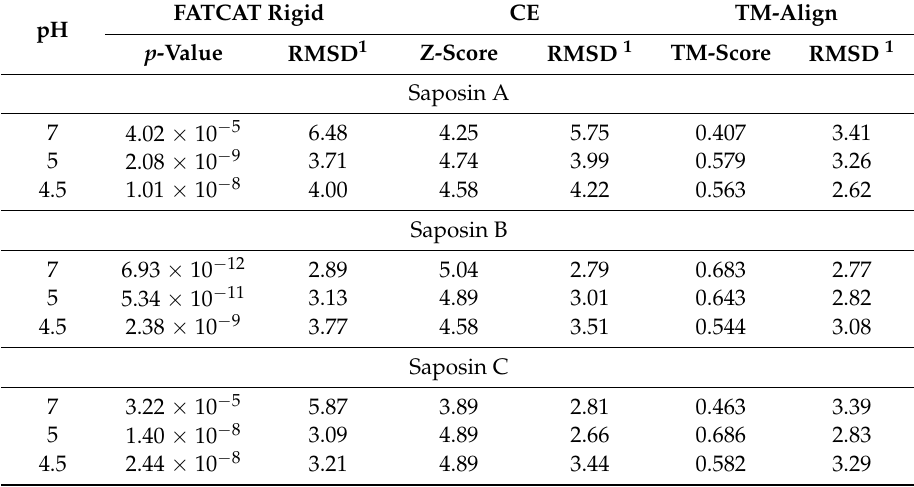
Table 4. Significance scores of structural superpositions of initial and final structures in 100-ns MD simulations of open forms of human saposins computed three structural alignment